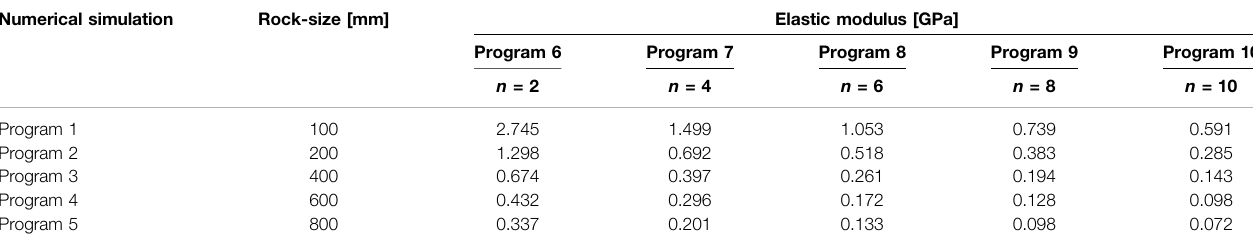
TABLE 2 | Elastic modulus of rock with different numbers of parallel-joints.